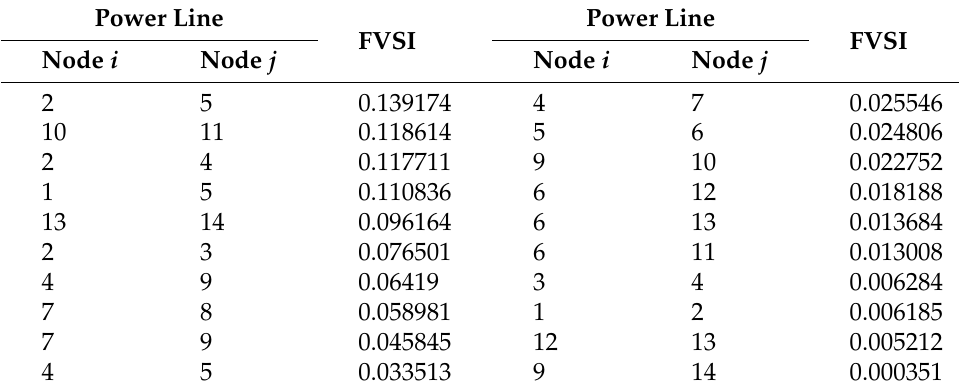
Table 1. FVSI for IEEE 14-bus-bar system before contingency